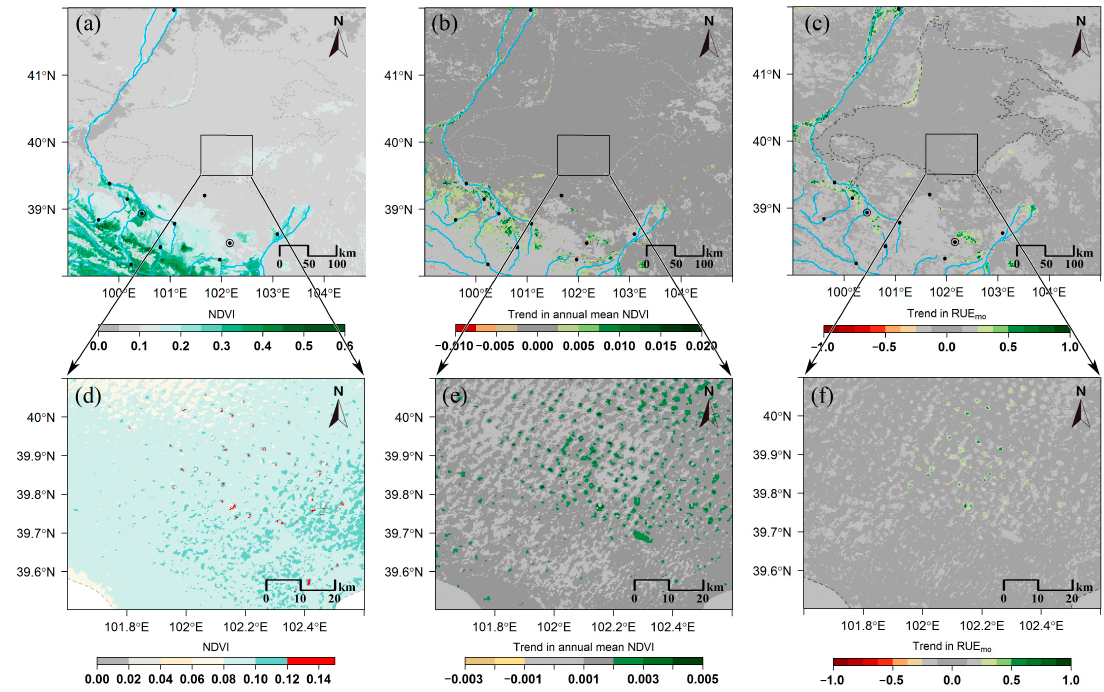
Figure 5. Spatial distributions of mean NDVI ( a , d ); significant NDVI annual trends ( p < 0.05) ( b , e );